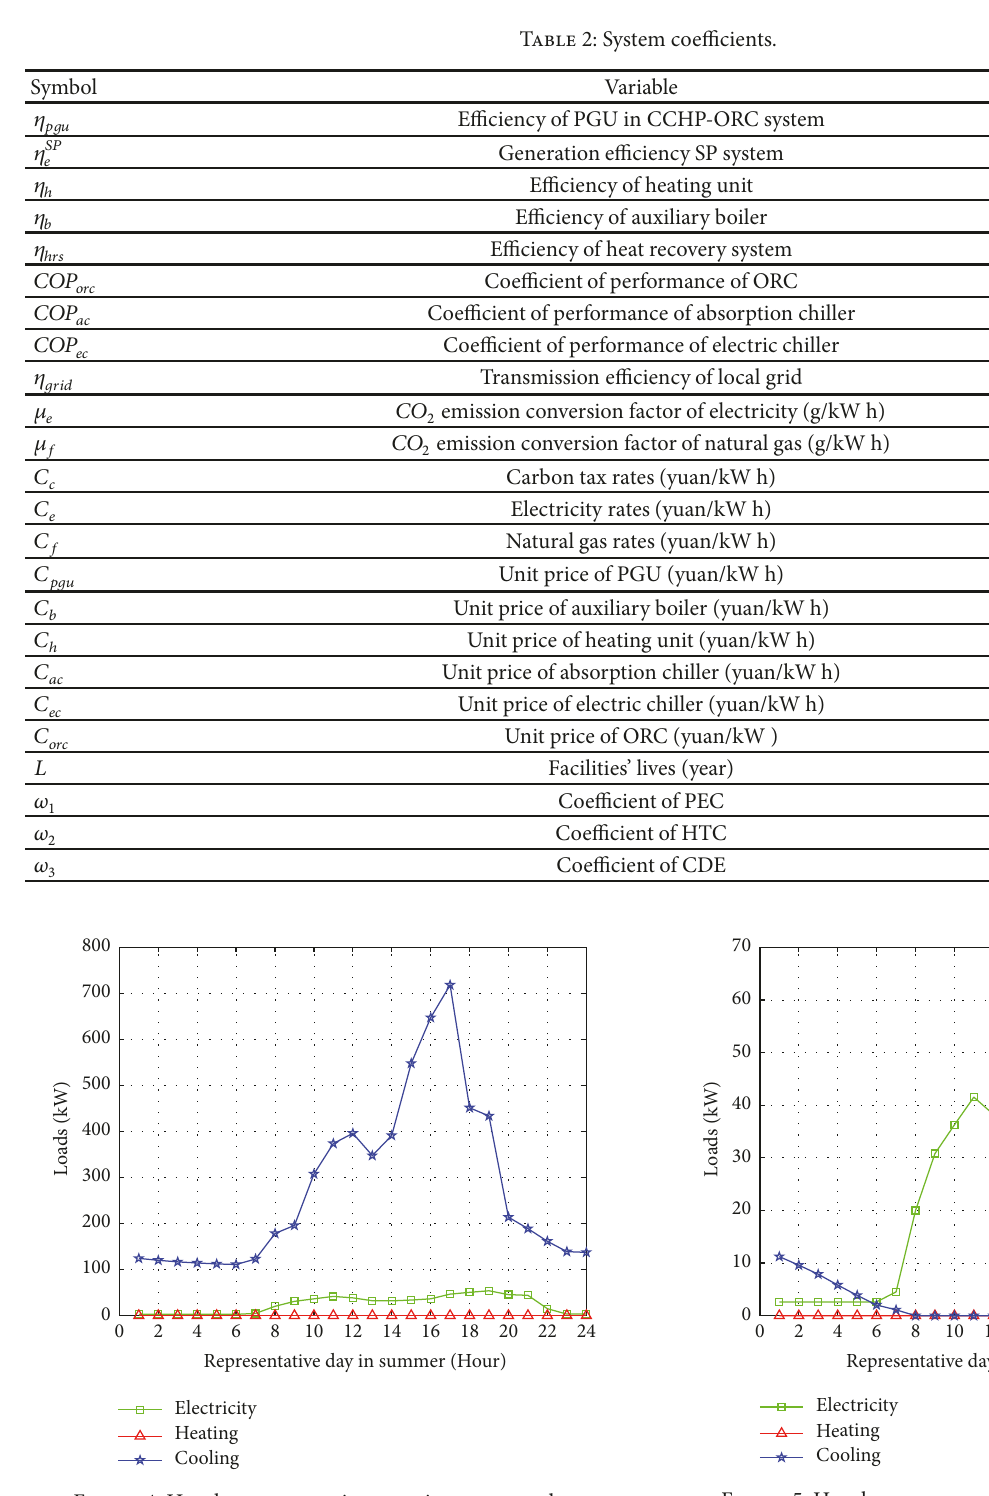
problem established in Section 3.2. In order to accelerate the convergence, some feasible initial points which are calculated from FEL and FTL strategies are manually designated. So